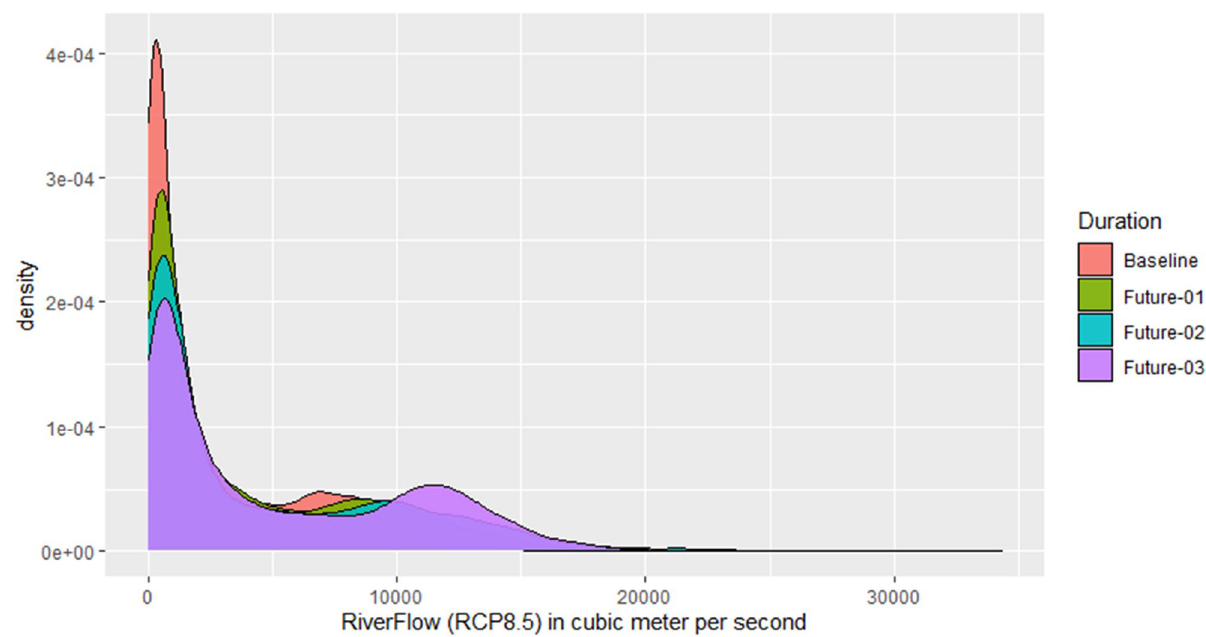
Figure 9. Similar to Fig. 8 but using the RCP8.5